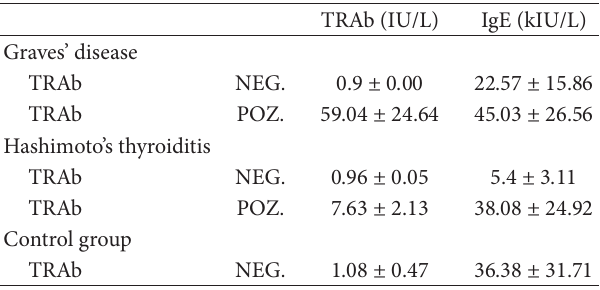
Table3:MeanserumIgElevelsamongpatientswithnormal(NEG.) and elevated levels (POZ.) of TRAb.